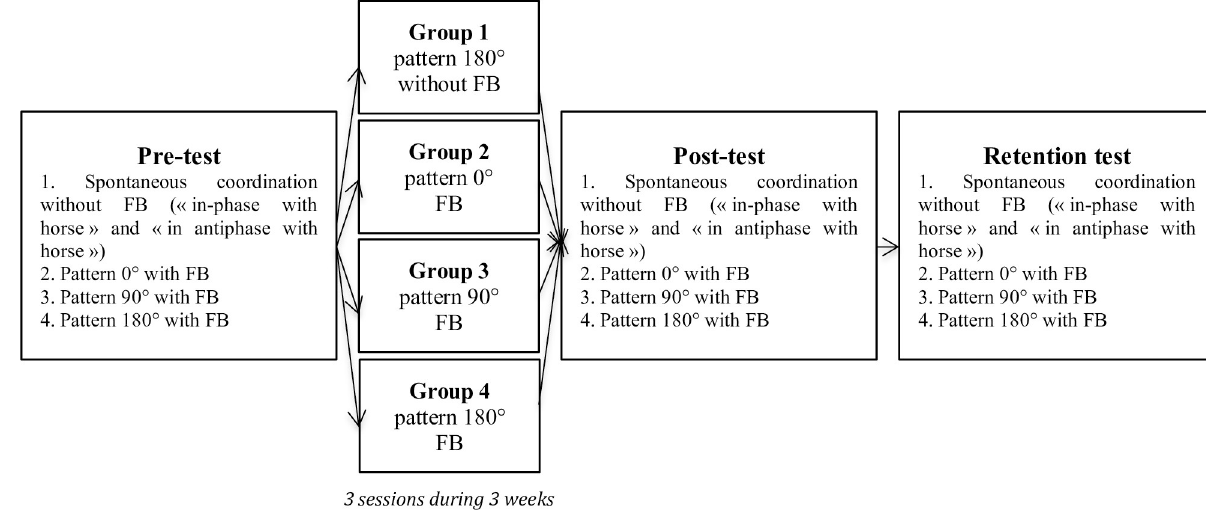
Fig 1. Protocol of study (FB corresponds to